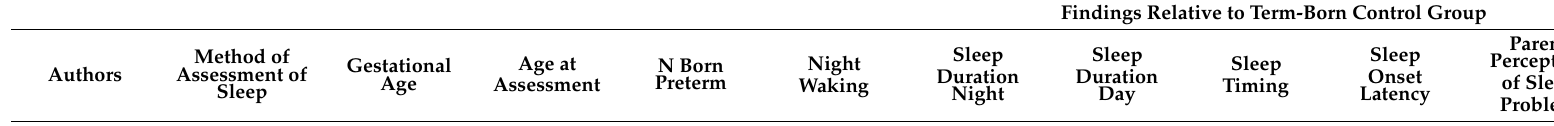
Table 2. Sleep following preterm birth in infancy and the pre-school